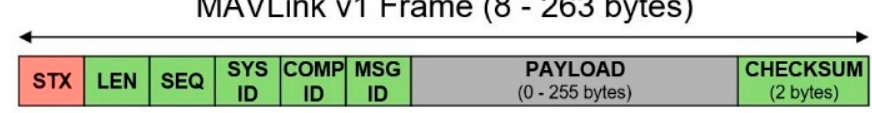
Figure 1. MAVLink protocol message [12].